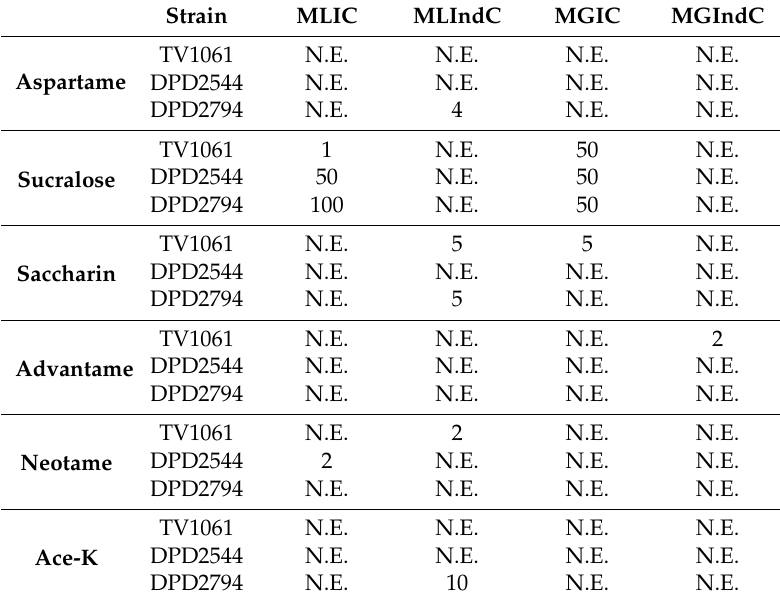
Table 1. Artificial sweeteners toxicity and viability effect